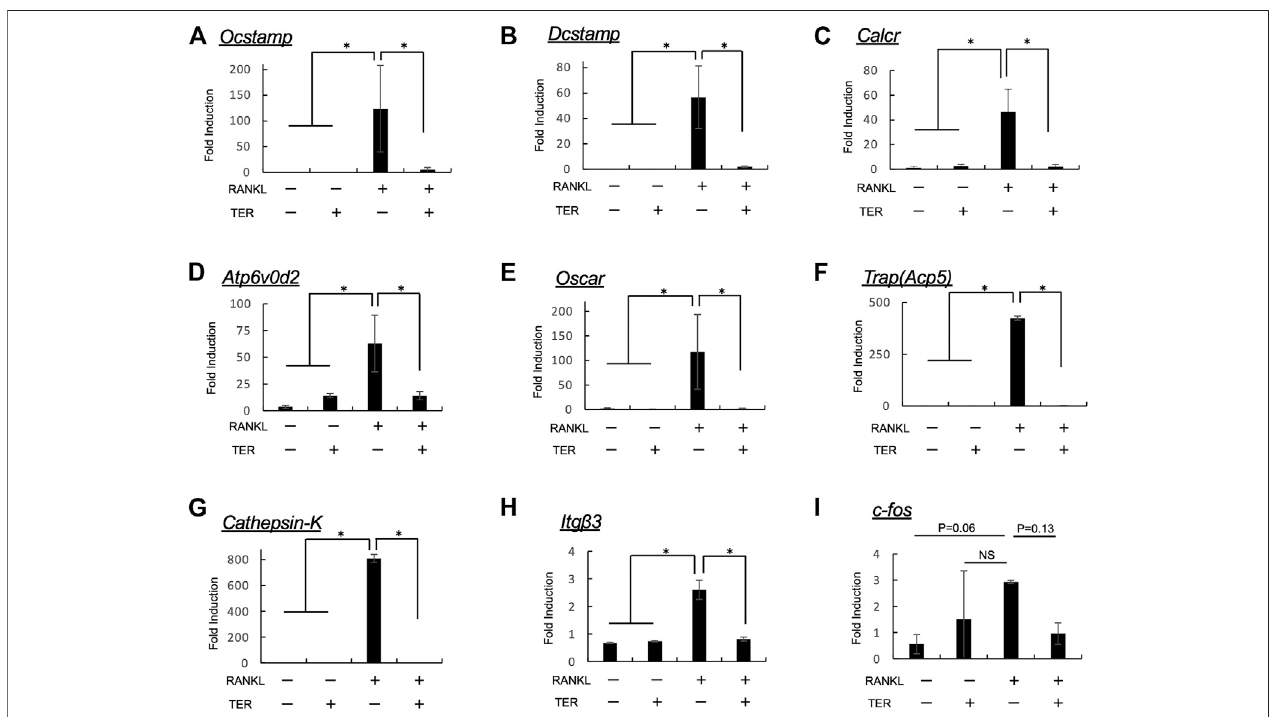
FIGURE 7 | SyntheticTERinhibitedRANKL-inducedmRNAexpressionofosteoclastogenesis-relatedfactors.MouseBMMs(1 × 10 5 cells/well)wereincubatedinserum- free medium containing RANKL/M-CSF (100 ng/ml each) in the presence and absence of synthetic TER (10 μ M) for 48 h. Cells were lysed, and the total RNA was subjected to real-time reverse transcription – polymerase chain reaction (RT-PCR) to determine Ocstamp , Dcstamp , Calcr , Atp6v0d2 , Oscar , Trap(Acp5) , Cathepsin-K , Itgb3 , and c-fos gene expressionlevels.Thecolumnsrepresentthemeanrelativeintensityof (A) Ocstamp , (B) Dcstamp , (C) Calcr , (D) Atp6v0d2 , (E) Oscar , (F) Trap(Acp5) , (G) Cathepsin-K , (H) Itgb3 , and (I) c-fos compared to that of β -actin carried out in triplicates, and bars represent the SD ( n (cid:1) 3, * p < 0.01, ns: not signi fi cant, ANOVA/Tukey – Kramer